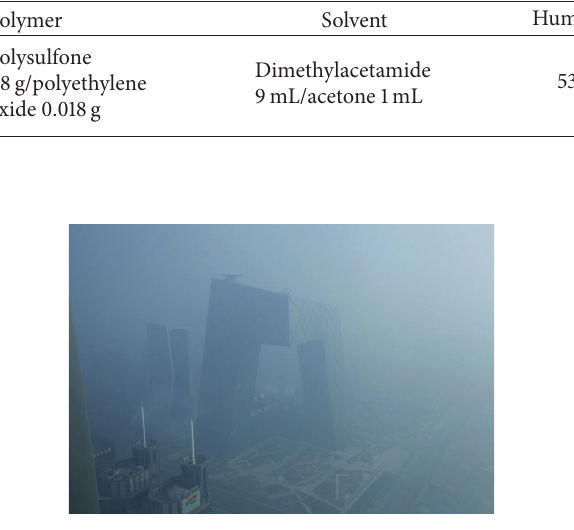
Figure 1: Typical haze in Beijing.